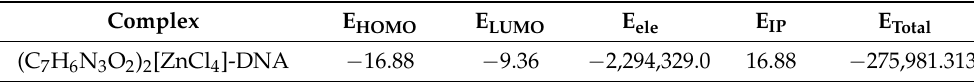
Table 3. Details of electronic descriptions calculated from molecular docking data.